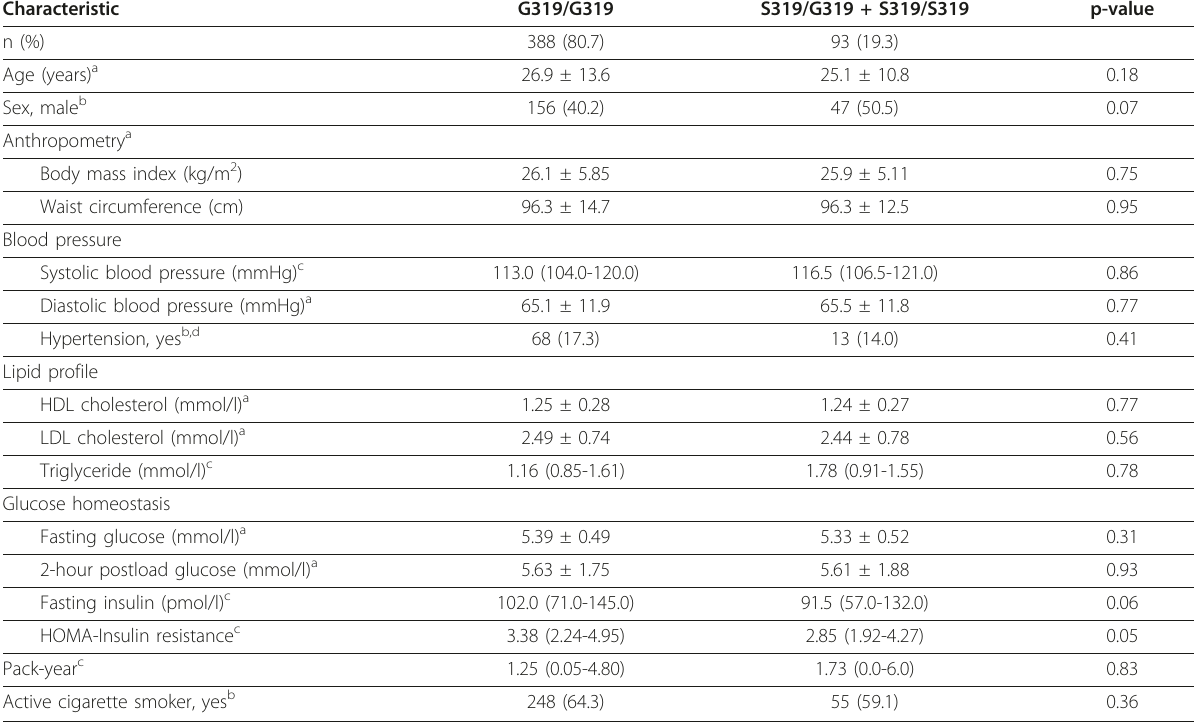
Table 1 Baseline characteristics of diabetes-free subjects according to the HNF1A G319S carrier status, the Sandy Lake Health and Diabetes Project (1993-1995) Characteristic